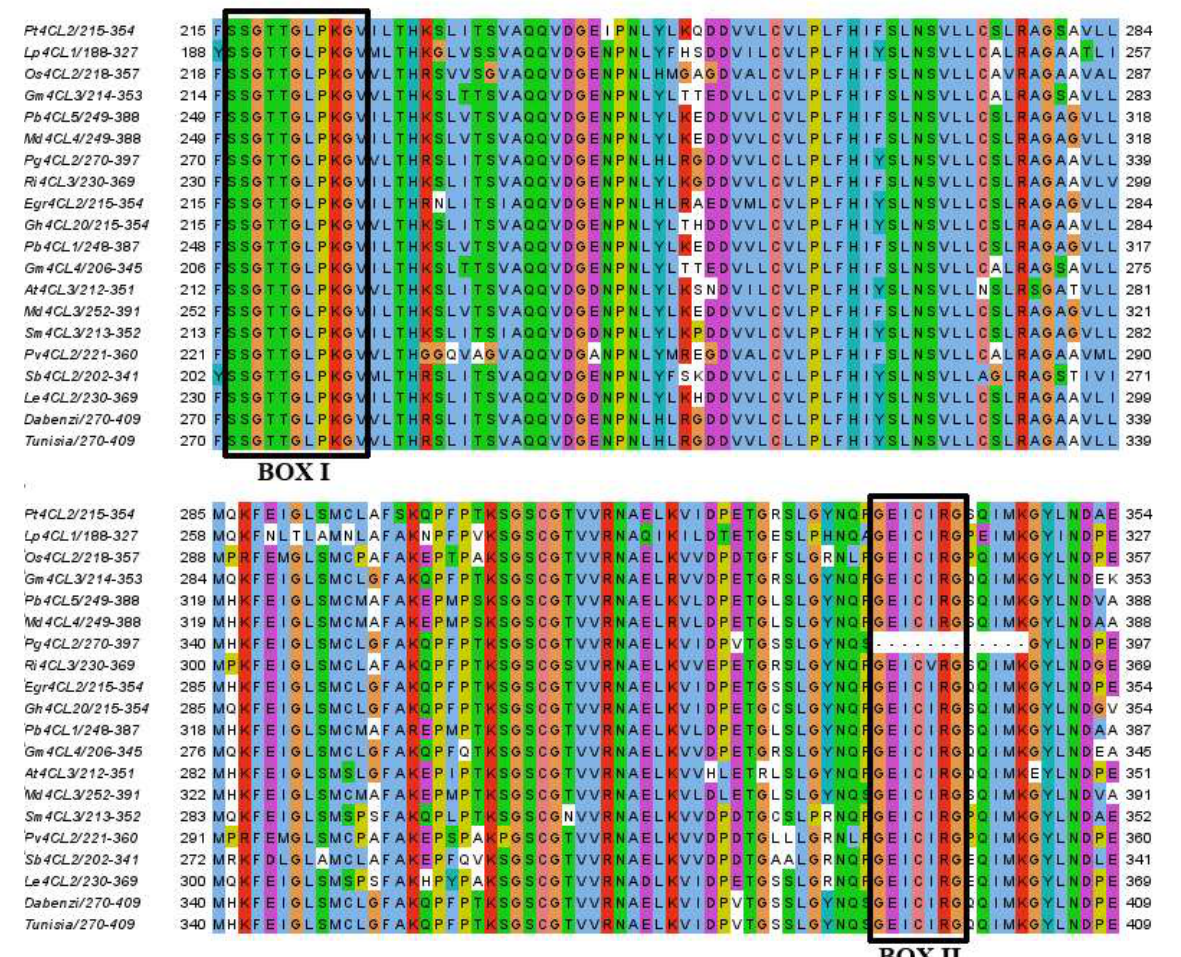
Figure 1. Multiple sequences alignment of At4CL3 with other plant homologous proteins. Note: the prefixes Pt, Lp, Os, Gm, Pb, Md, Ri, Egr, Gh, At, Sm, Pv, Sb, and Le stand for Populus tremuloides , Loblolly pine , Oryza Sativa , Glycine max , Pyrus bretschneideri , Malus domestica , Rubus idaeus , Eucalyptus grandis , Gossypium hirsutum , Arabidopsis thaliana , Salvia miltiorrhiza , Panicum virgatum , Sorghum bicolor , and Lithospermum erythrorhizon , respectively. ‘Dabenzi’ and ‘Tunisia’ belong to pomegranate. The Pg001327.1 gene was amplified from the cDNA of ‘Taishanhong’ by PCR (Figure 2). The DNA was collected and sequenced after cloning. The total length of the PCR products was 1738 bp. The sequencing results were compared with pomegranate ‘Taishanhong’ genome sequence Pg001327.1 and ‘Tunisian’ genome sequence XP_ 031382283.1 (Figure 3), reaching 90.14% and 92.05%, respectively, with high homology. The Pg001327.1 gene was missing 36 nucleotides within positions 1404–1439 bp. Following the nucleotide positions of Pg001327.1 and XP_031382283.1, the Pg001327.1 nucleotide deletion sequence ‘GGT- GAAATTTGTATTCGAGGCCAACAGATTATGAAAGG’ was translated, and the amino acid sequence was ‘GEICIRGQQIMK’, which contained Box II (GEICIRG), indicating that the deletion of amino acid sequence Box II of Pg001327.1 was caused by genome sequencing and assembly errors. According to the sequencing results, the sequence information of the genome Pg001327.1 was supplemented with missing nucleotides, and the corrected sequence was used for subsequent bioinformatics